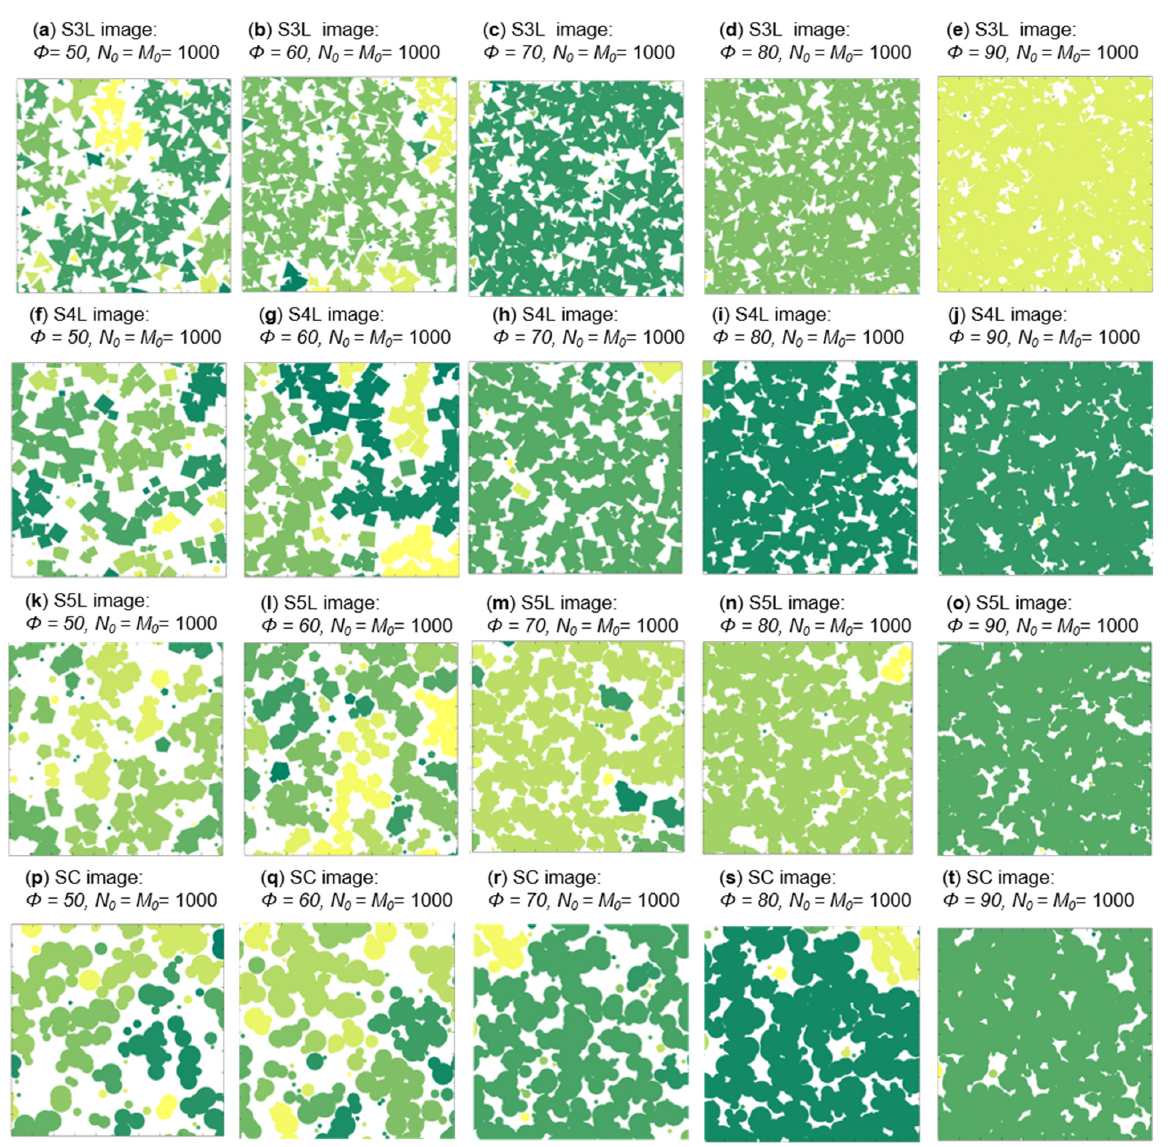
Figure 11. Percolation evaluation for the agglomerate phase of Figure 7 in a surface fraction range of 50% to 90%. ( a – e ) show percolation results for S3L images, ( f – j ) show percolation results for S4Limages, ( k – o ) show percolation results for S5L and ( p – t ) show percolation results for SC images. Table 1. Percolation for agglomerate and matrix